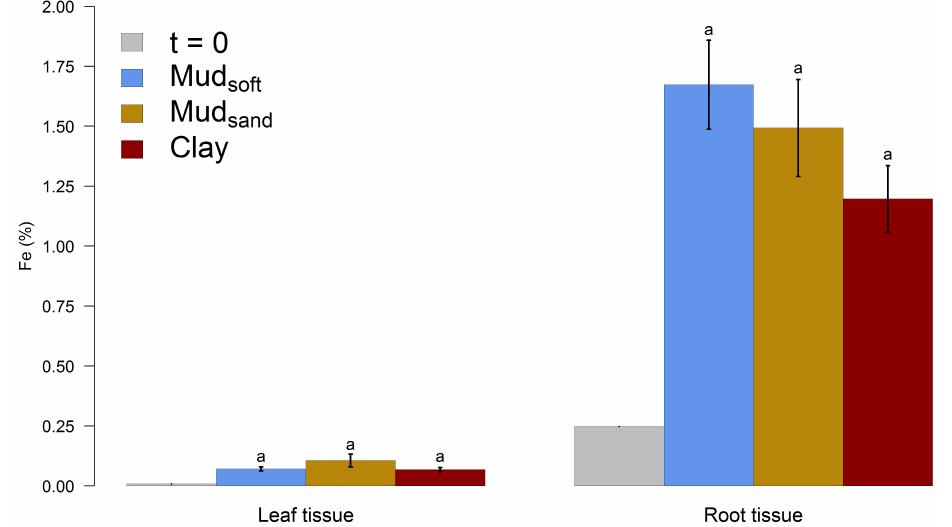
Figure 5. Fe concentration (% of dry weight) in leaf and root tissue with error bars when n = 5. Significant differences between sediment types are indicated by different letters, and nonsignificant differences are indicated by the same